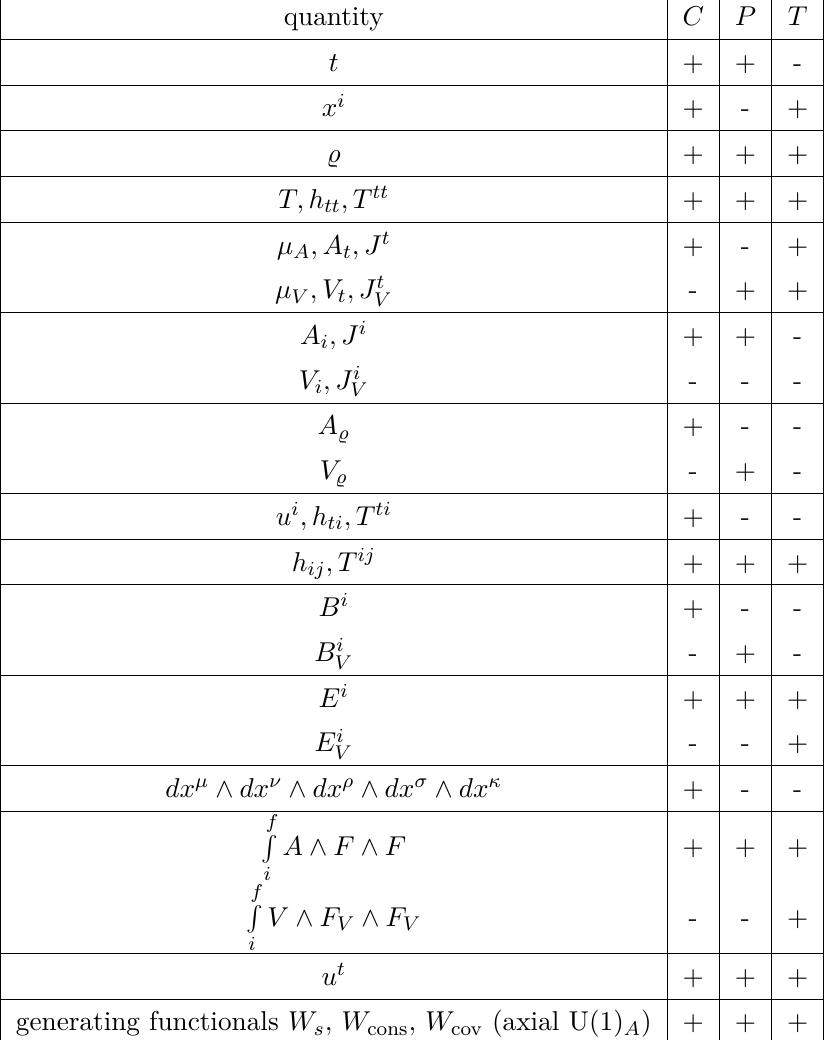
Table 6 . Transformation properties of the following quantities under charge-parity C , parity P , and time-reversal T : field theory coordinates x µ = t, x, y, z , field theory axial U(1) U(1) ) current J µ (or J µ ) and energy-momentum tensor T µν , hydrodynamic variables T, u µ , V V